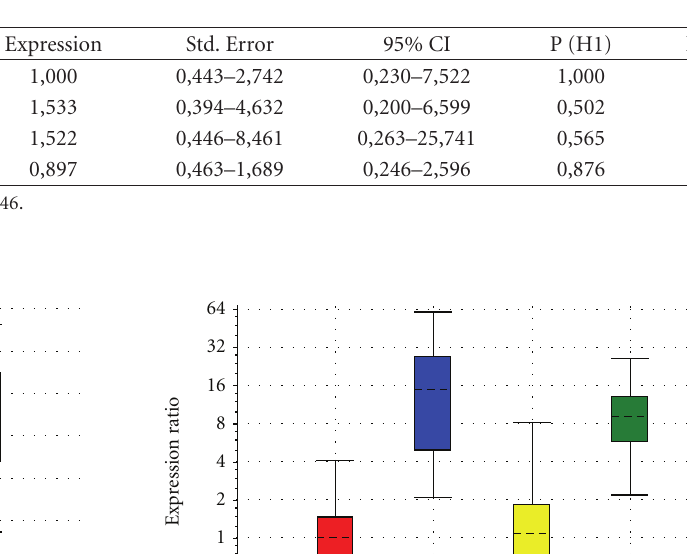
Table 4: Statistical analysis summary of results obtained from ginseng versus control after processing RT-PCR data through REST (Relative Expression Software Tool) in 40th day.